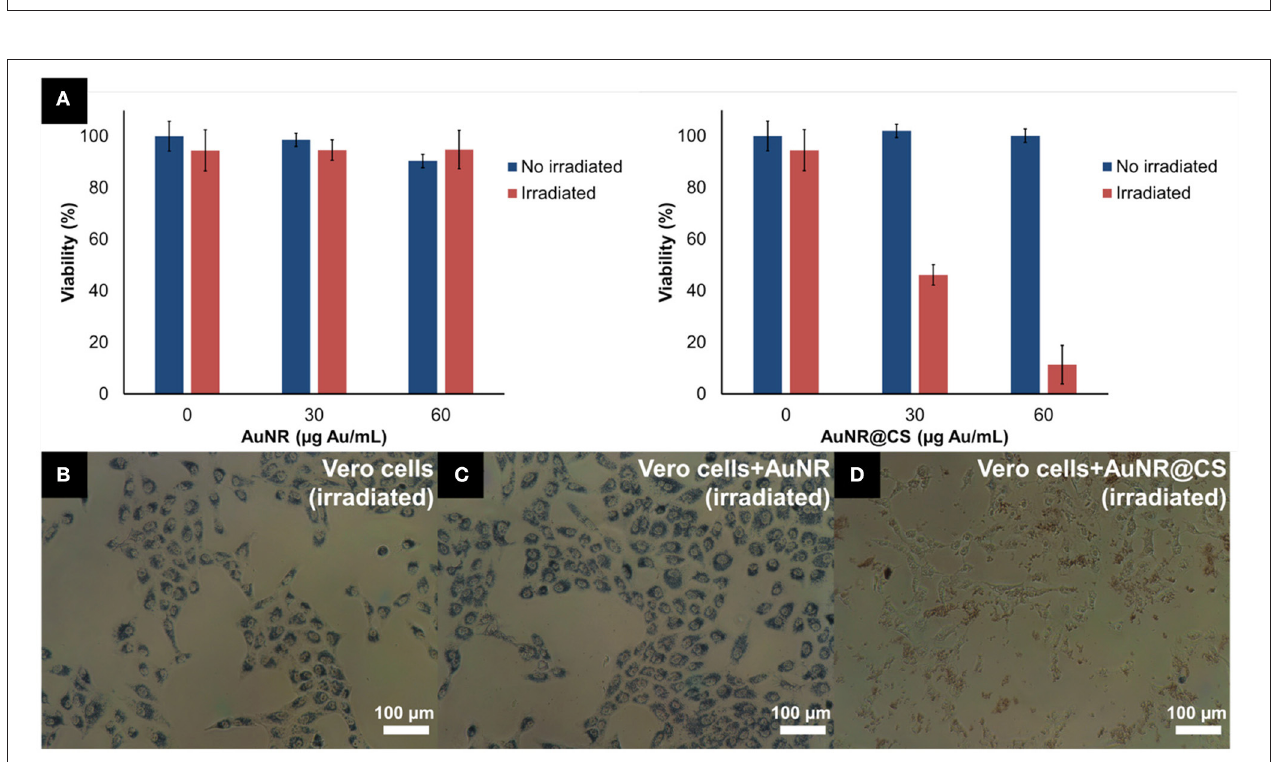
FIGURE 4 | (A) MTT cell viability of Vero cells incubated with different concentrations of AuNR or AuNR@CS 5h after laser irradiation. (B–D) Phase contrast microscopy images of cells during MTT incubation, after irradiation: untreated cells (B) , 60 µ g/mL of AuNR (C), or 60 µ g/mL of AuNR@CS (D) .